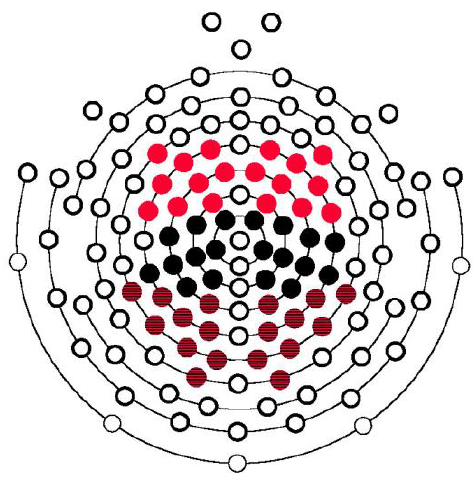
Figure 1. Position of electrodes included in final event-related potentials (ERP) data analysis. Electrodes highlighted in red represent left and right anterior electrodes, in black left and right central electrodes, and in striped red and black left and right posterior electrodes.